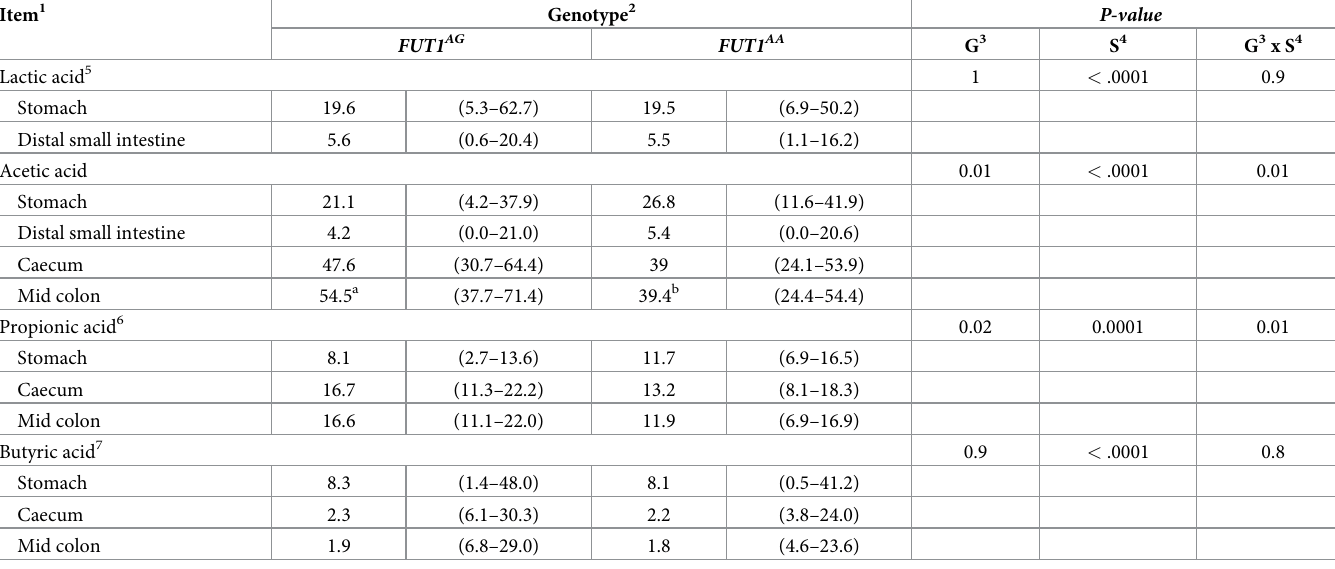
Table 5. Organic acid concentrations in digesta (mmol/kg wet sample) from the gastrointestinal tract of 34 days old piglets (one week post-weaning) belong to FUT1 AG and FUT1 AA